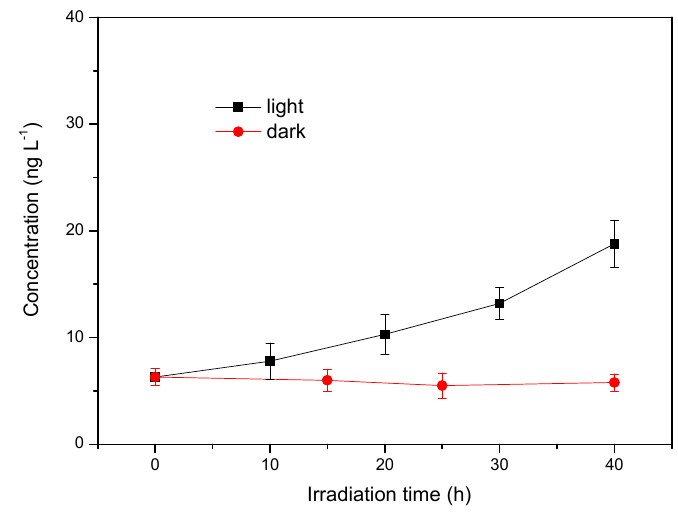
Figure 9. Methyl chloride production in natural seawater from Northern Yellow Sea, China. Reaction conditions: light intensity = 12 mW cm − 2 .